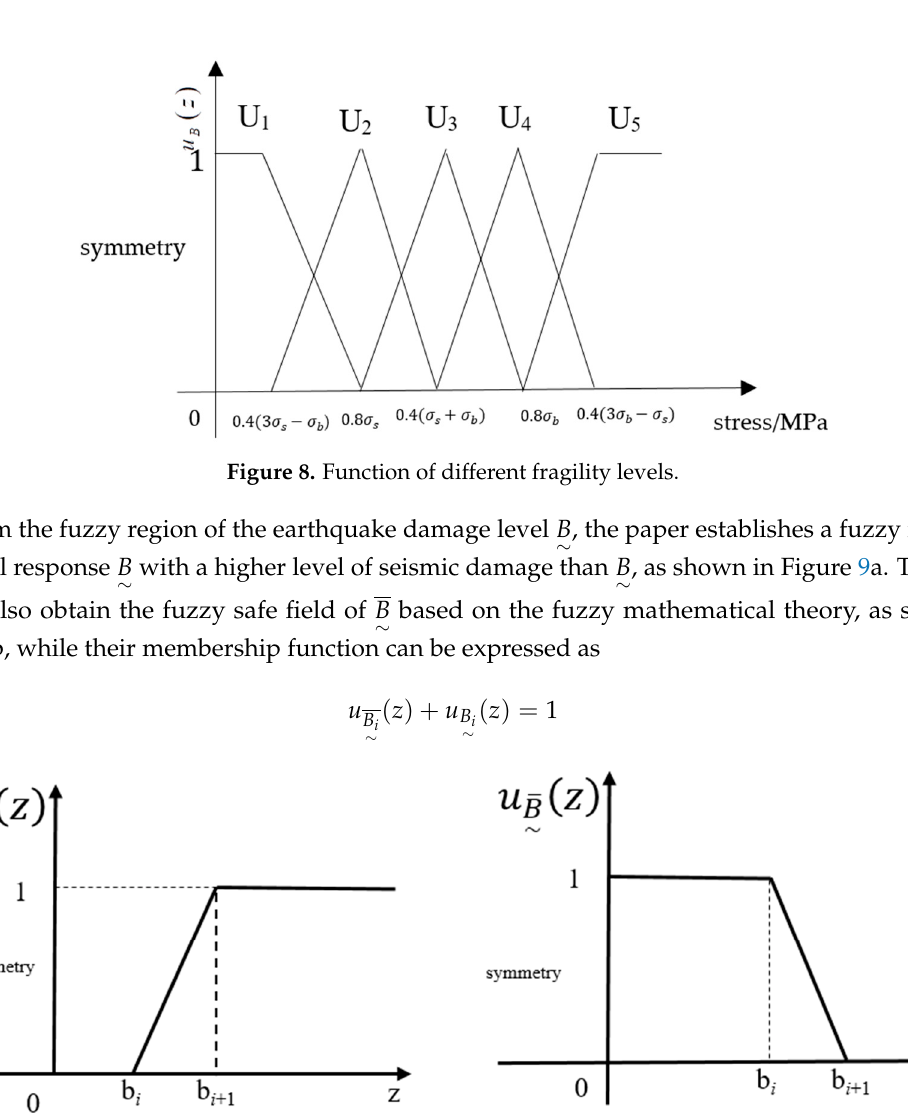
Figure 9. Membership function of the fuzzy damage field. ( a ) Fuzzy fail field; ( b ) Fuzzy safe field.